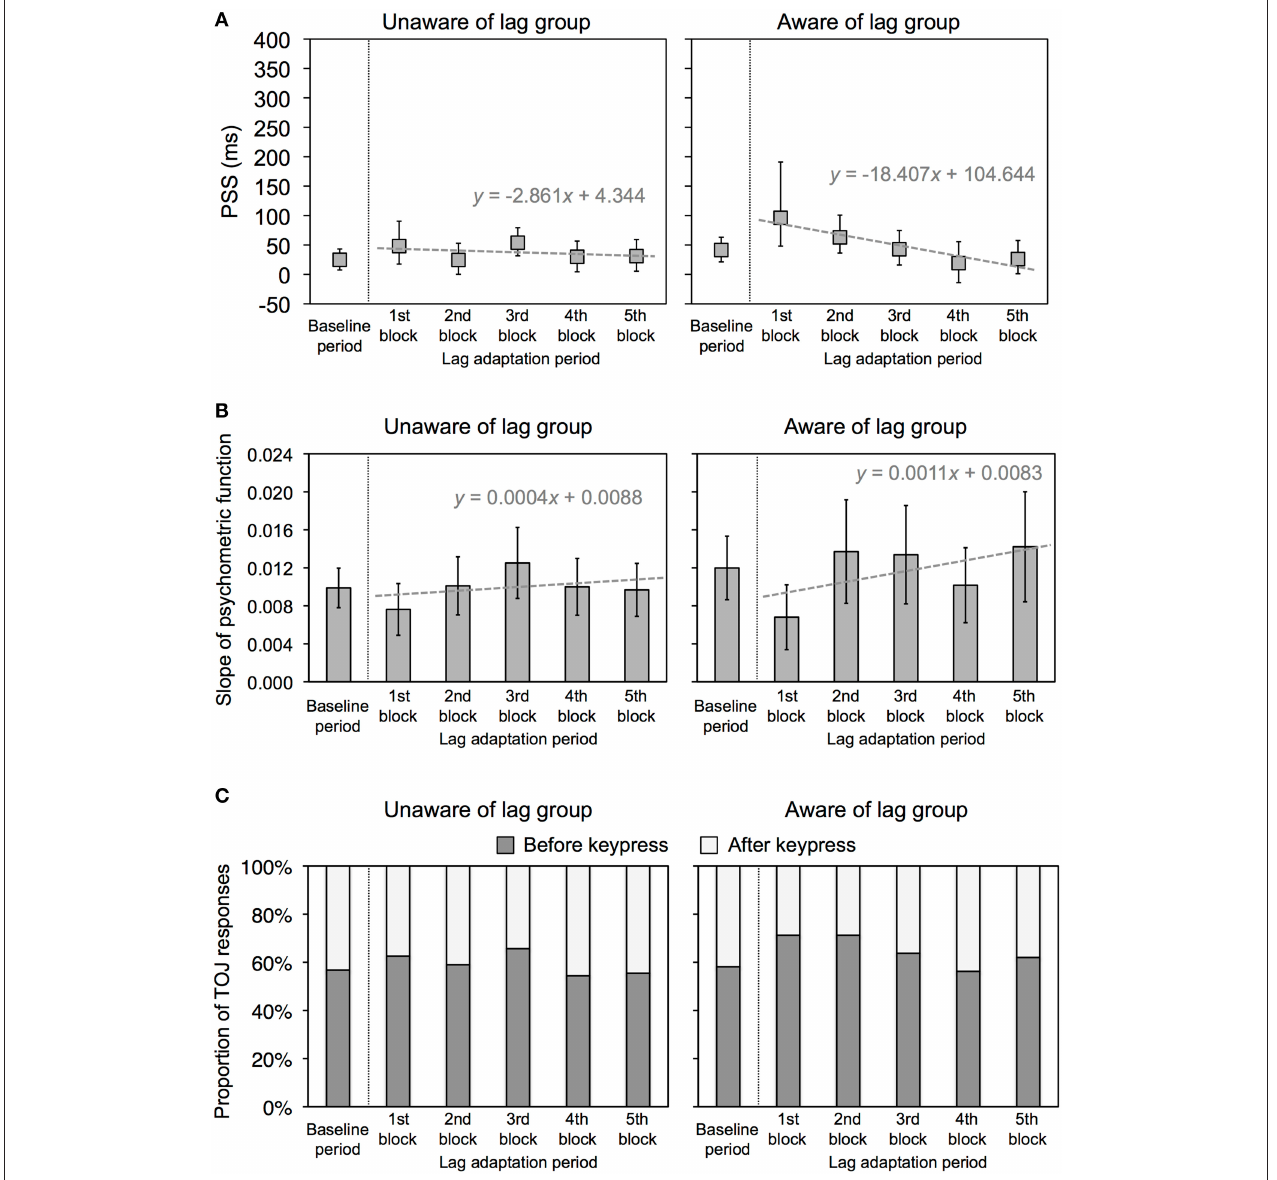
FIGURE 5 | Results of Experiment 2. (A) PSS for unaware and aware of lag groups in Experiment 2. Positive values in the PSS show that a test flash was presented after the sixth keypress. Error bars show a 95% confidence interval obtained from Probit analysis. Dotted gray lines show a regression line fitted to the PSSs at the lag adaptation blocks, with a regression equation. (B) Slope of psychometric function for unaware and aware of lag groups in Experiment 2. Error bars show a 95% confidence interval obtained from Probit analysis. Dotted gray lines show a regression line fitted to the PSSs at the lag adaptation blocks, with a regression equation. (C) Proportion of TOJ responses for unaware and aware of lag groups in Experiment 2. Dark and light gray bars respectively represent responses that a test flash was perceived before and after the sixth